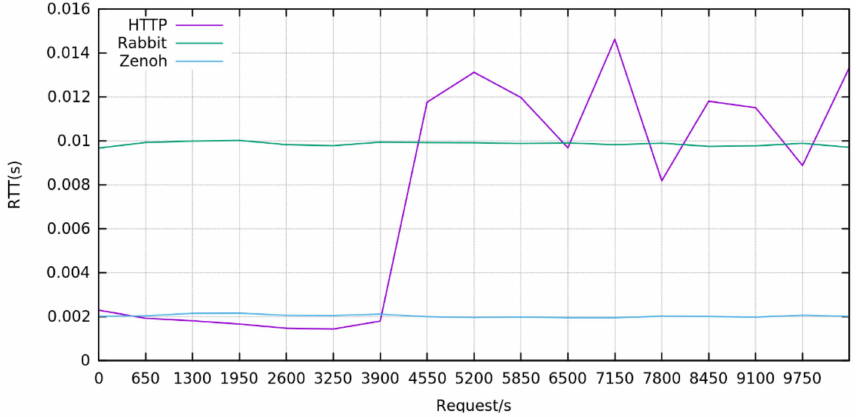
Figure 5. Round trip time of requests when traversing 2 hops with an increasing number of requests per second, starting from 0 up to